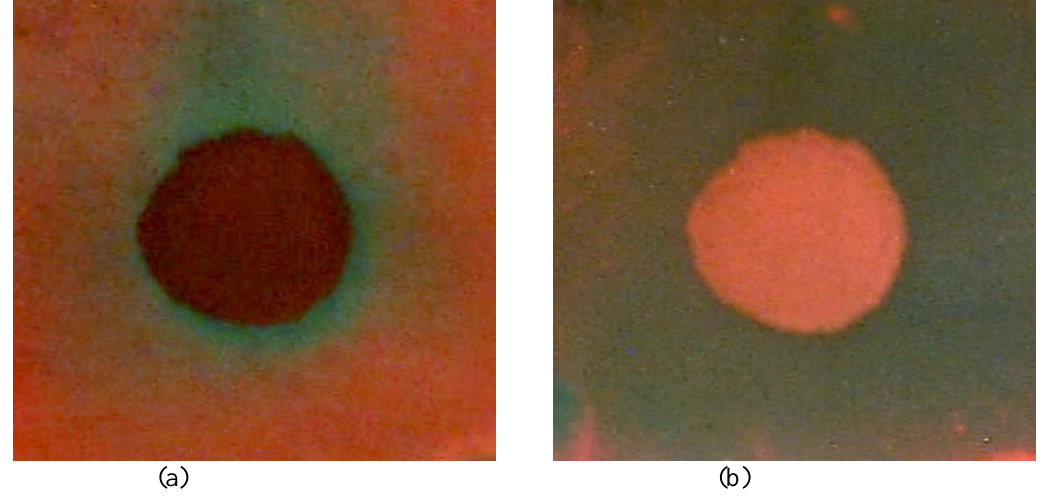
FIGURE 4. Smokeless powder spot on chromatography paper treated with europium-OP before water rinse (a) and after water rinse (b), as detected by photoluminescence. See text. Upland, CA) operating in the deep UV, and were then converted to black and white, with blue suppression, because the luminescence of free OP is not of interest. Results obtained with RDX were similar to the above smokeless powder ones. Results were also comparable when the europium complex was replaced by the corresponding green-emitting terbium complex, for both smokeless powder and RDX. Results were similar, but not nearly as good, with the corresponding TTFA complexes (under near UV), because the TTFA ligand acts somewhat as a negatively charged moiety (OP acts neutral), which tends to inhibit the binding (electrostatic repulsion) to the explosive (whose binding oxygen also displays negative charge characteristics) and because the TTFA ligand is not as easily displaced by water as the OP ligand, binding more strongly to the lanthanide cation (electrostatic attraction). Under the near UV excitation appropriate to the TTFA ligand and study of smokeless powder, the powder spots themselves (acetone extraction) on the chromatography paper exhibited a green fluorescence of the same color (on visual inspection) as the Tb emission, though dim in comparison. In the sensitivity study below we focused on the Eu complex with OP, and smokeless powder and RDX, spotted as before in